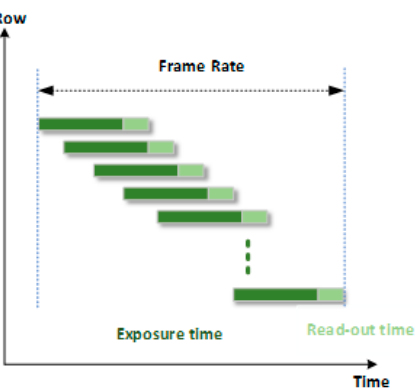
Figure 1. Rolling shutter mechanism of metal-oxide-semiconductor (CMOS) sensor.